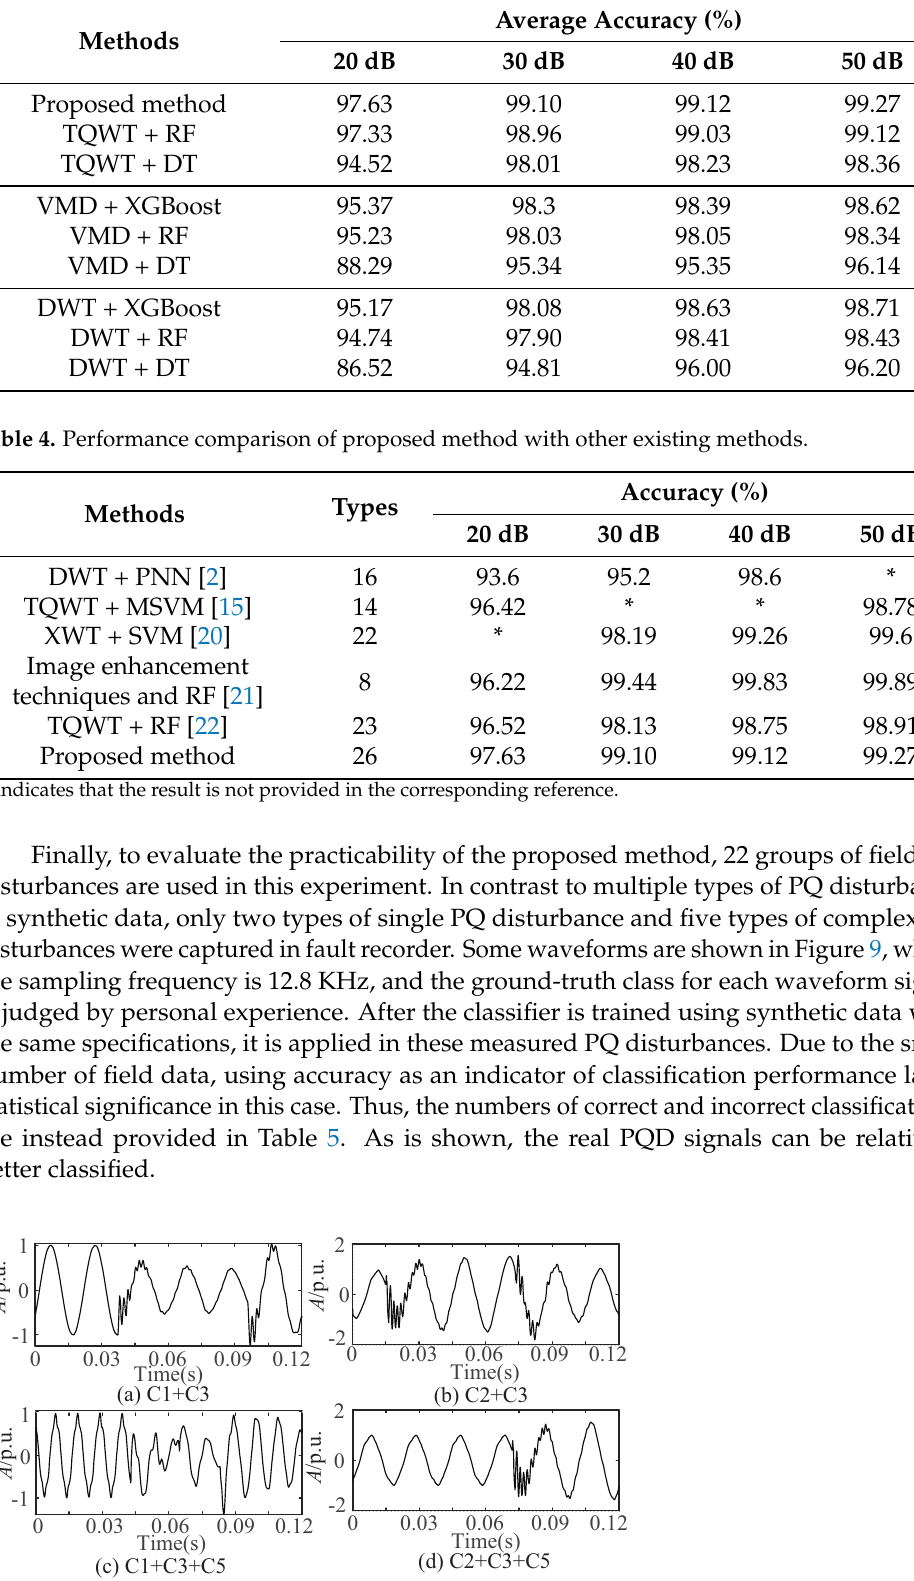
Figure 9. The field PQ disturbance signals captured in fault